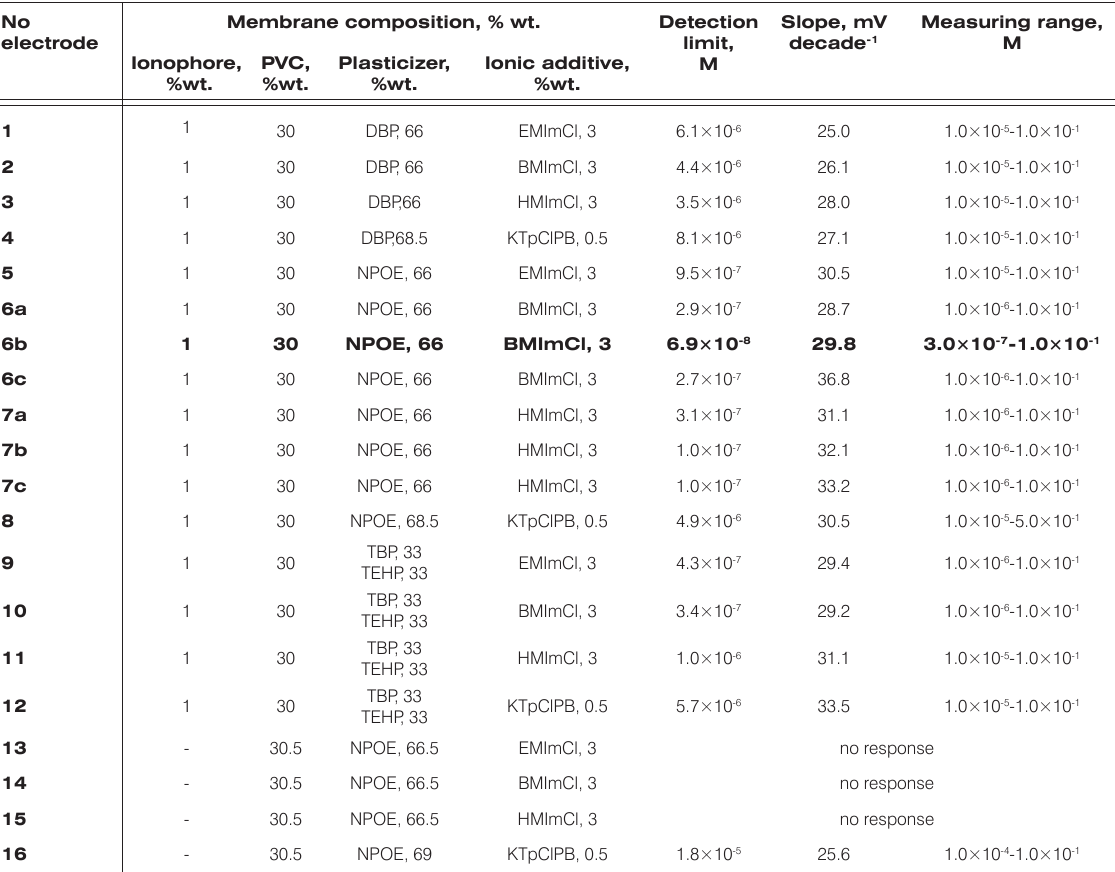
Table 1. Composition and optimization of membrane ingredients; optimized values are bold. No Membrane composition, % electrode